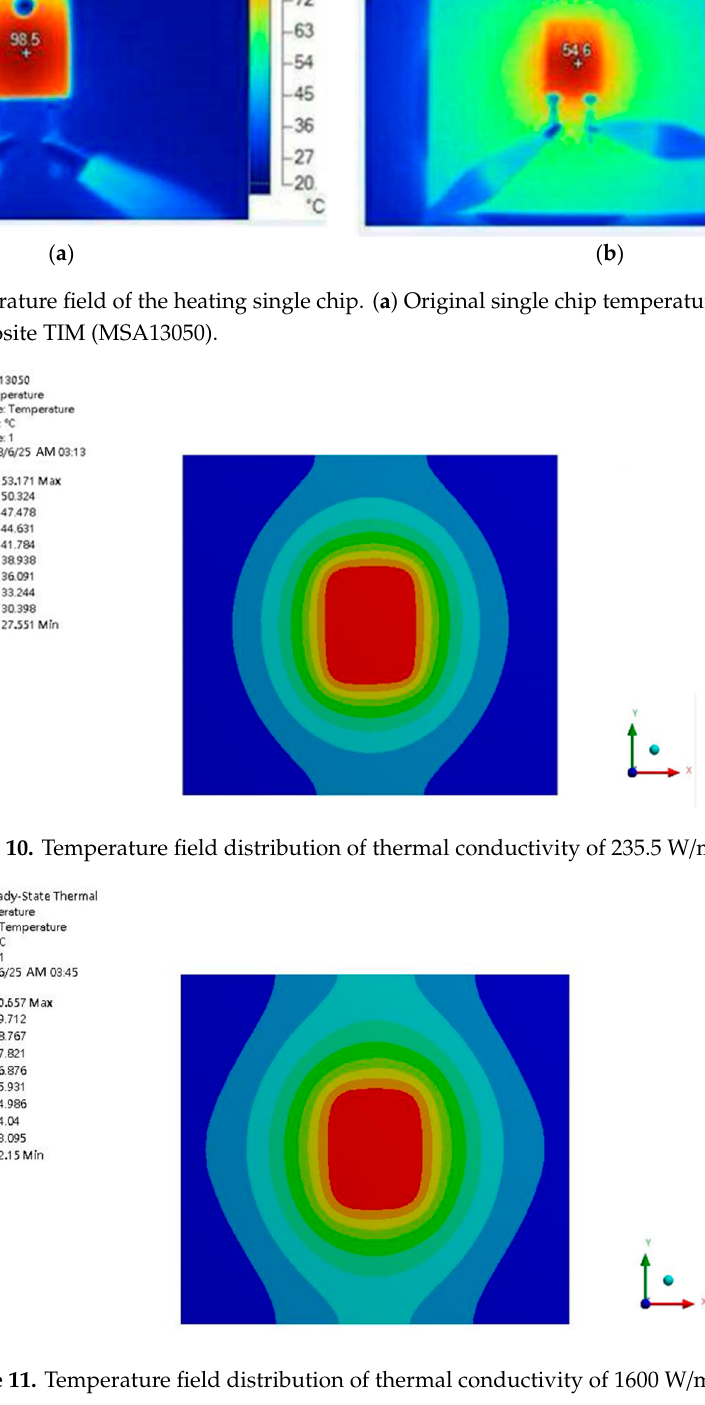
Figure 11. Temperature field distribution of thermal conductivity of 1600 W/mK.